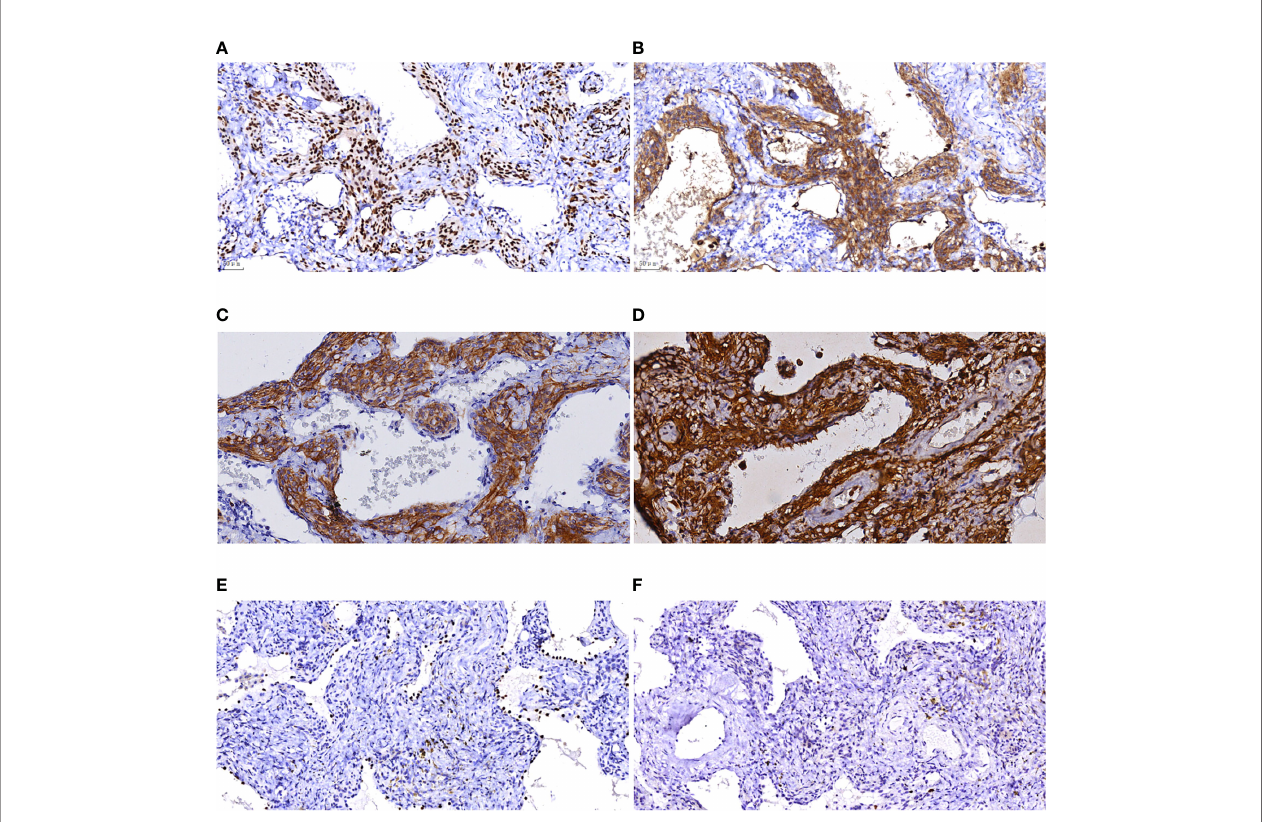
FIGURE 4 | Immunohistochemical results of MPMNs. (A) x200 The cells were nuclear positive for PR; (B) x200 The cells were cytoplasmic positive for EMA; (C) x200 The cells were cytoplasmic positive for CD56; (D) x200 The cells were both nuclear and cytoplasmic positive for vimentin; (E) x200 Normal type II alveolar epithelial cells were positive and meningeal epithelial-like cells were negative for TTF-1; (F) x200 The number of Ki-67 positive cells was